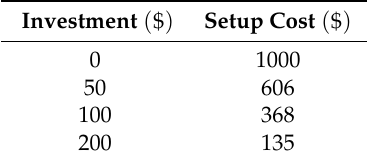
Table 2. Setup cost investment data.